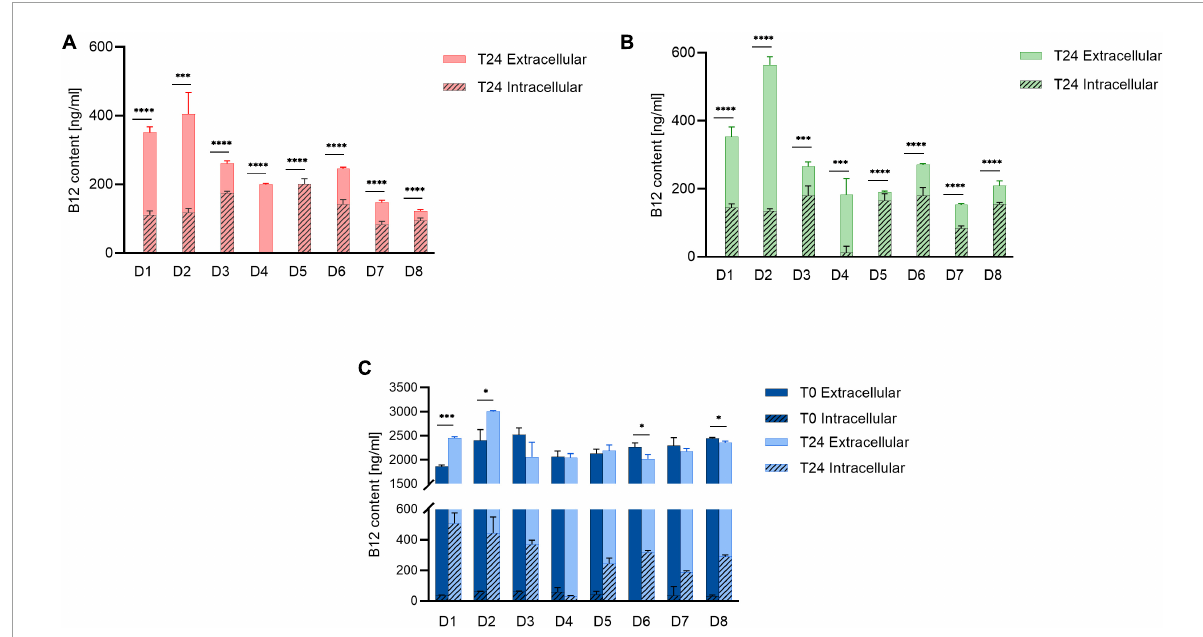
FIGURE2 Intracellular and extracellular B12 content of (A) Control, (B) NB12, and (C) ExtraB12 treatments at T0 and T24 for fecal microbiota of eight donors (D1–D8), measured by UHPLC-DAD. B12 content at T0 for control and NB12 treatment was below detection limit (i.e., < 30 ng/ml). Data are mean and standard deviation of three replicates. An unpaired t -test was performed on total B12 (sum of intra- and extracellular) to test the significance between T0 and T24, per donor. Asterisk ( ∗ ) represents significant differences between condition, per each donor ( ∗ for P < 0.05, or ∗∗∗ for P < 0.001, or ∗∗∗∗ for P <